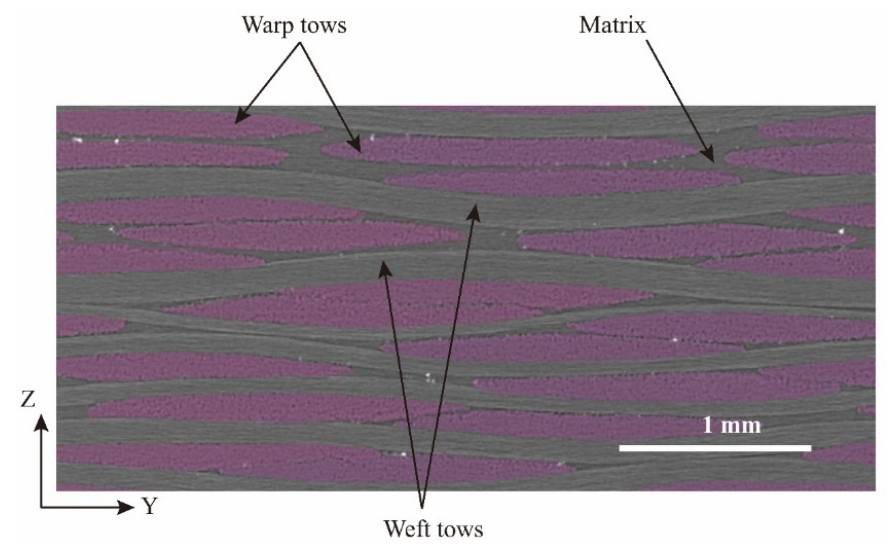
Figure 9. A typical Y–Z slice image of the T300/Cycom970 plain-woven fabric composite. Table 2. Geometric parameters of fiber tows in the T300/Cycom970 plain-woven fabric composite. Geometric Parameter Value 1.82